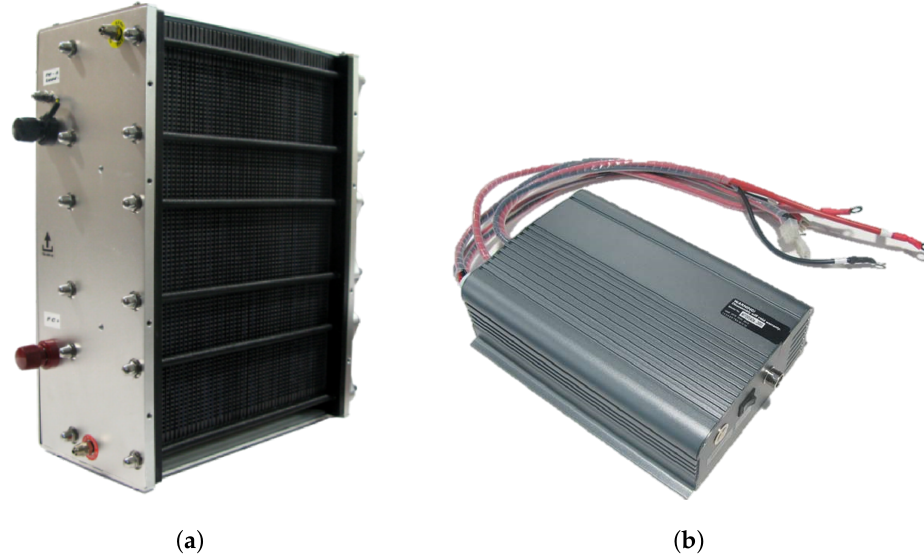
Figure 2. Horizon H-2000 PEMFC Stack ( a ) and its OEM controller ( b ). Images retrieved [25].